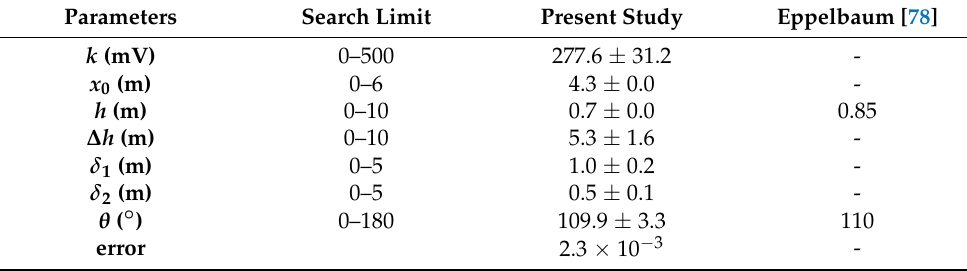
Table 6. Interpretation of Archaeological investigation, Halutza, Southern